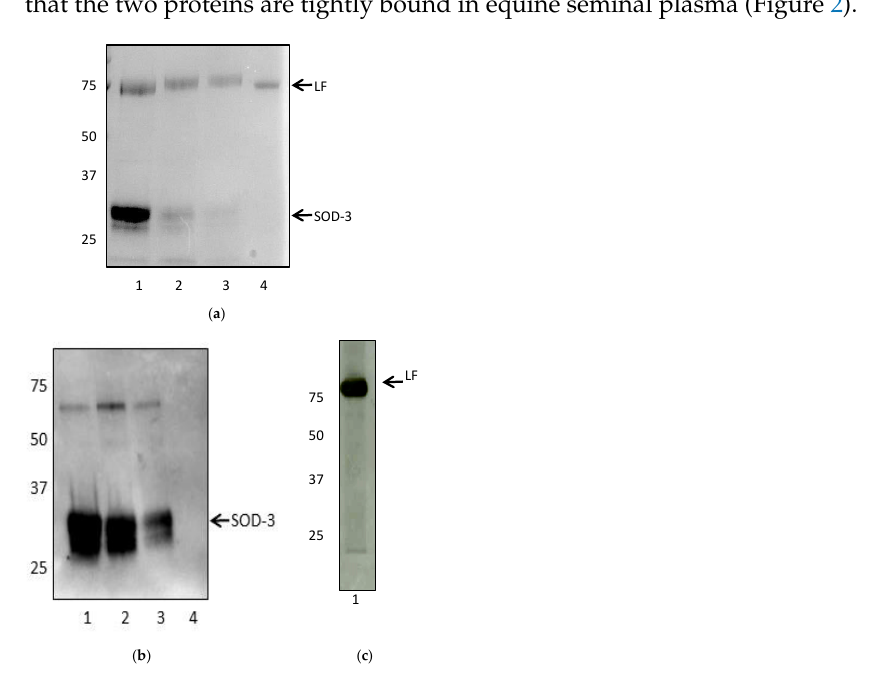
Figure 2. ( a ) SDS-PAGE of multiple attempts to isolate lactoferrin (80 kDa) from seminal plasma (lanes 1 – 3). A second protein at 32 kDa consistently co-eluted with lactoferrin. Lane 4: Recombinant human lactoferrin. ( b,c ): Western Blots of SOD-3 LF. ( b ) Western blot using anti-SOD-3 antibody (1:1000, SCBT, sc-67088) identified the second protein as SOD-3. Lanes 1 – 3: Lactoferrin purified using different methods. Lane 4: Recombinant human lactoferrin. ( c ) Western Blot using anti-lactoferrin antibody (1:1000, SCBT, sc-14434) of purified lactoferrin (lane 1).